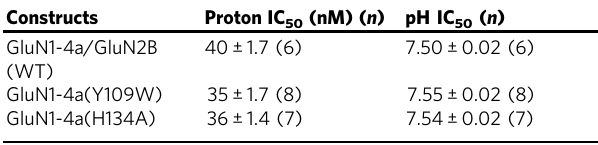
Table 4 Results of TEVC proton concentration – response experiments with inhibiting GluN1-4a/GluN2B mutants